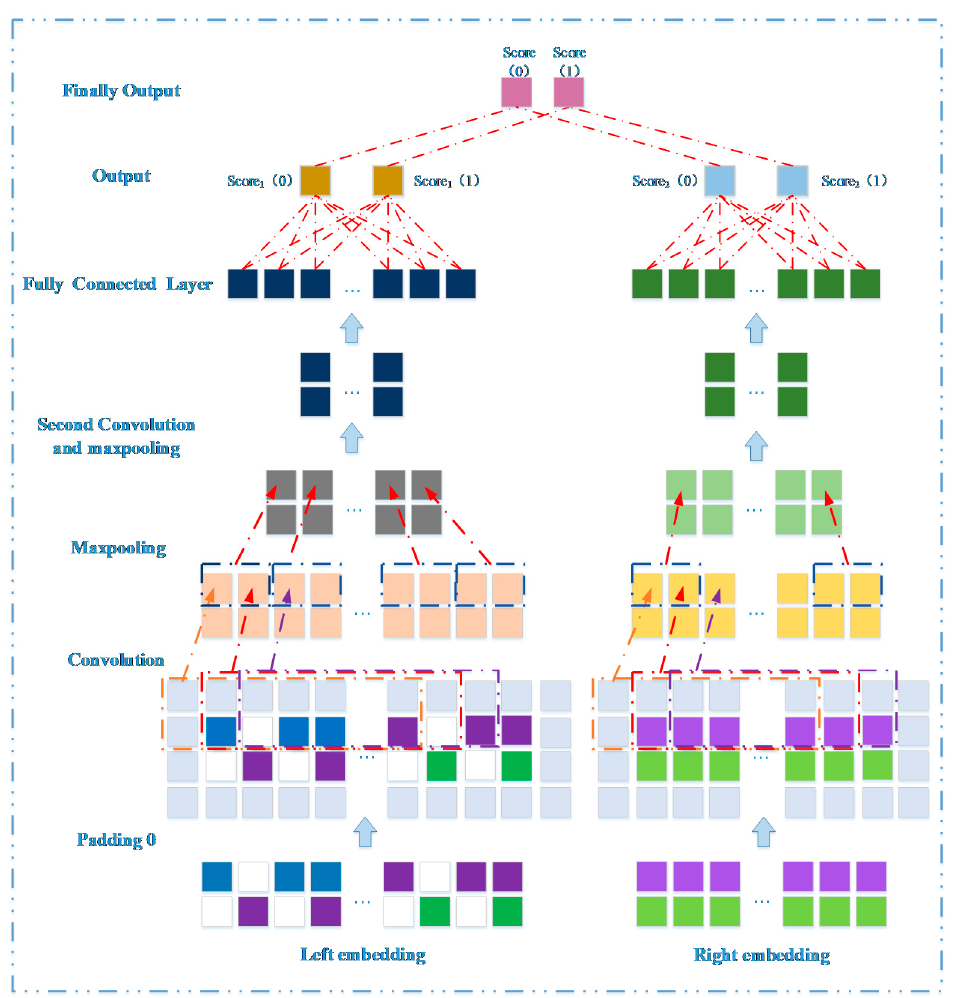
Figure 4. Construction of a deep learning framework based on dual convolutional neural networks to learn original representation and global network representation.